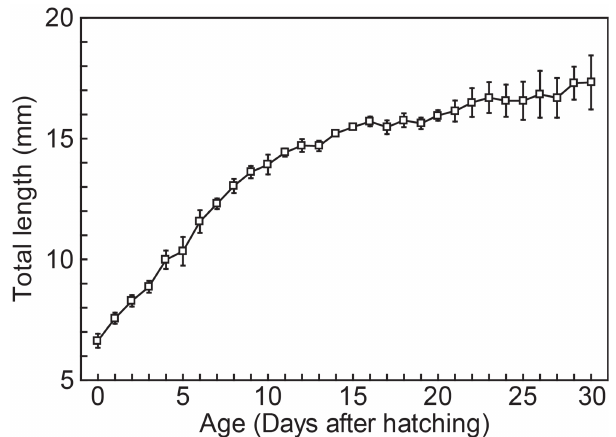
Fig. 2. Mean ± standard deviation of total length of Lophiosilurus alexandri larvae in relation to age.